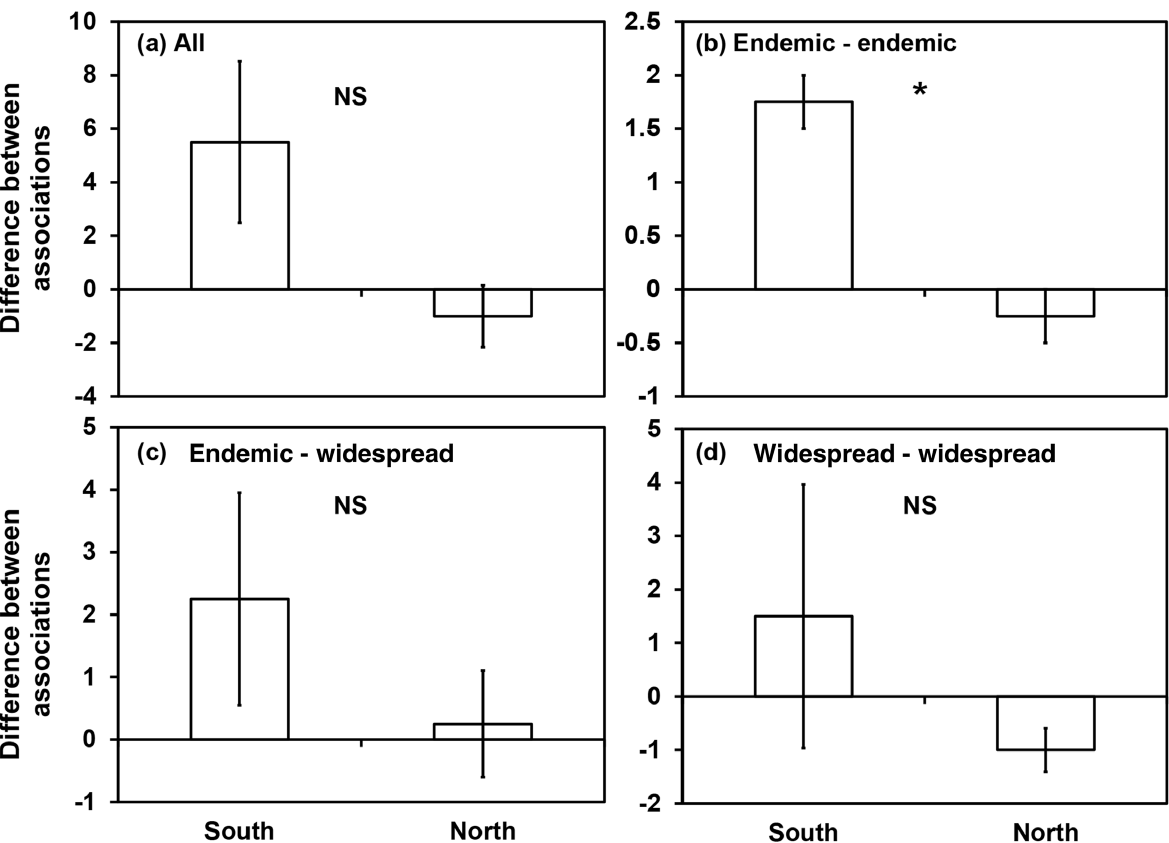
Figure 6. Average (±SEM) differemce between aggregated and segregated species associations south and north of Point Conception: (a) all species associations, (b) associations between narrow-range endemic species, (c) associations between narrow-range endemic and widespread species, (d) associations between widespread species. In all cases, aggregated associations were more common south of Point Conception than north. (N = 4 sites per